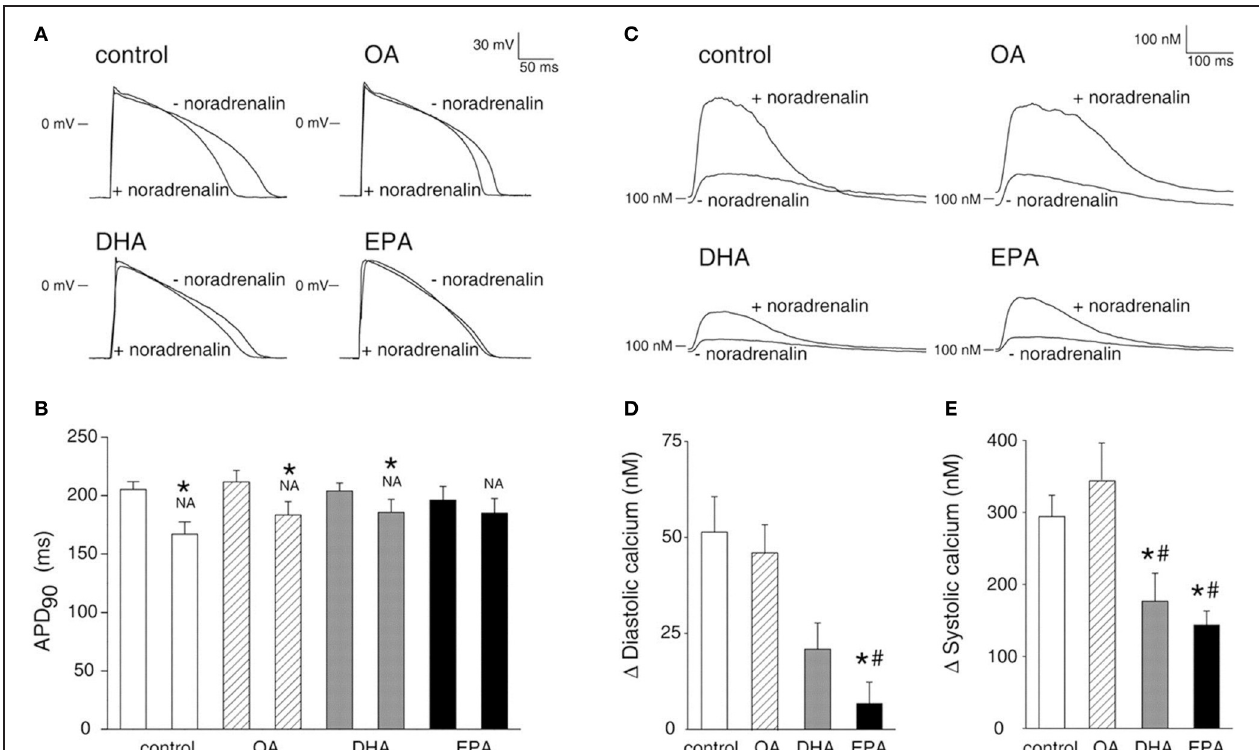
FIGURE 2 | PUFA reduce the sensitivity to noradrenalin. (A) Effects of free Oleic acid (OA), free EPA and free DHA on AP duration before and after application of noradrenalin. (B) Mean data for AP duration. ∗ P < 0 . 05 indicates statistical differences with or without noradrenalin. (C) Effects of free OA free EPA and free DHA on calcium transient before and after